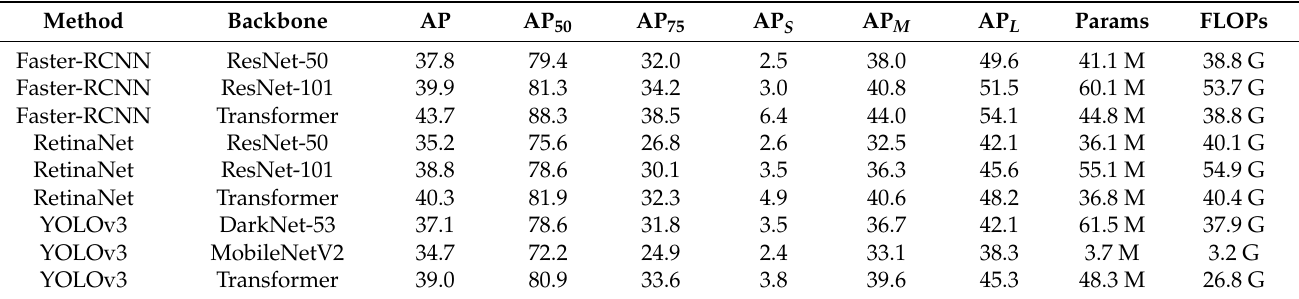
Table A1. Use different backbones for wheat head